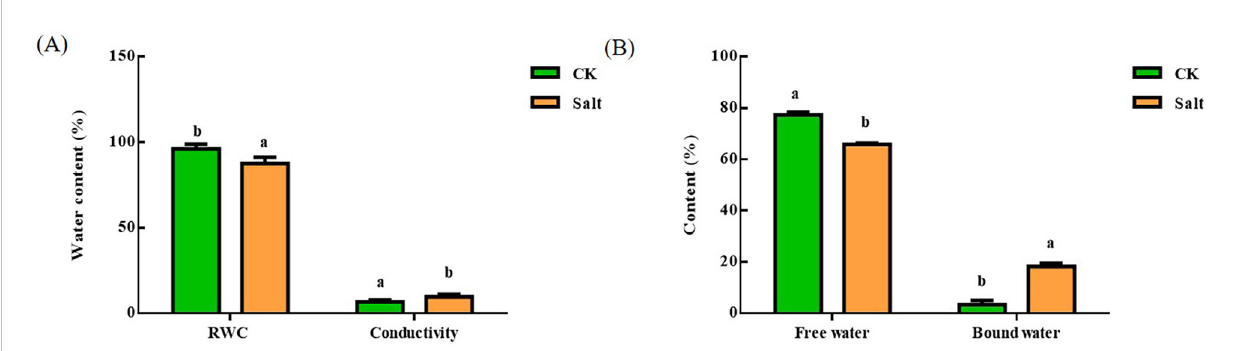
FIGURE 2 Effect of salt stress on the relative water content, conductivity and free water bound water content of ginger seedling leaves. (A) Relative water content and electrical conductivity. (B) Free and bound water. The lowercase letters a and b mean the letter markers for signi fi cant difference analysis.